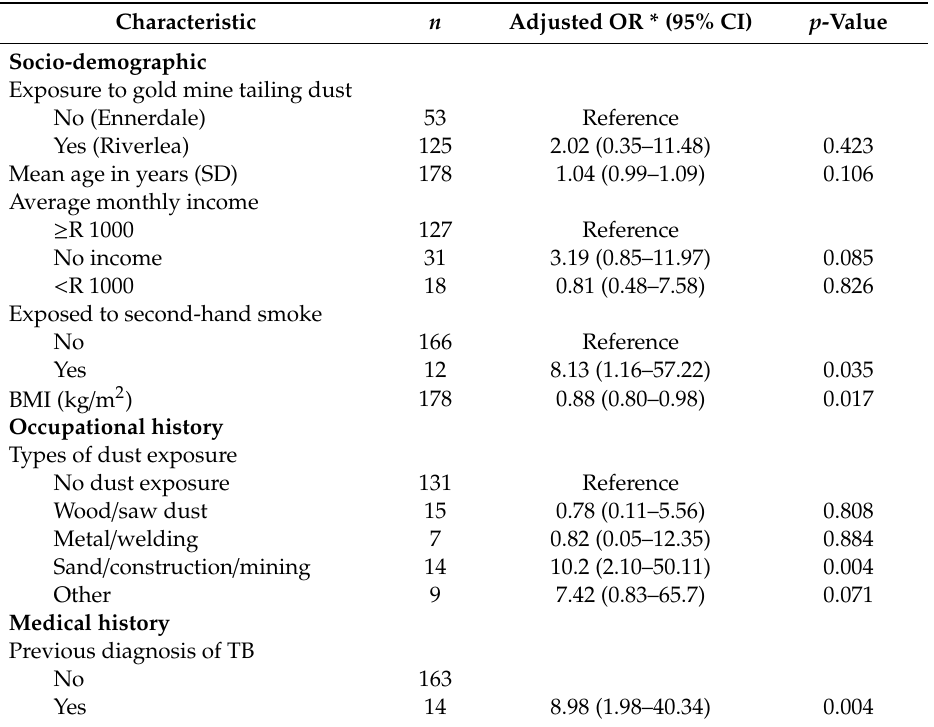
Table 3. Multivariate logistic regression analysis of factors associated with radiological